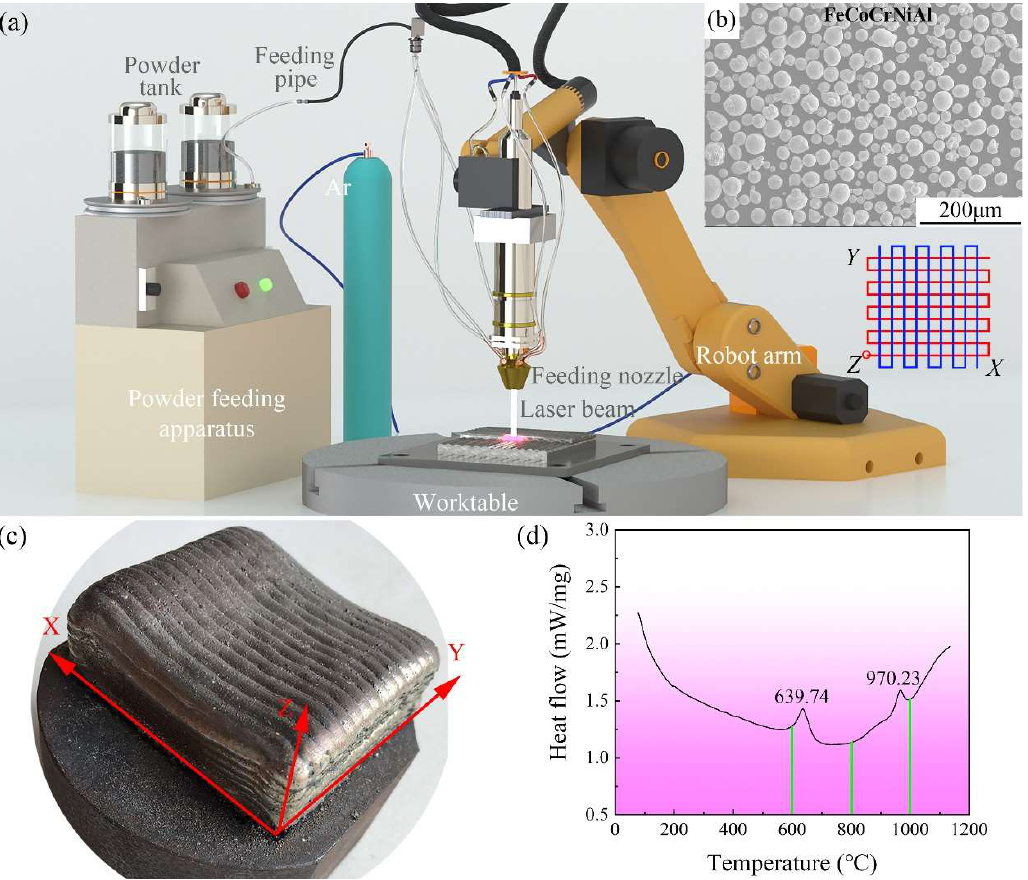
Figure 1. ( a ) Laser-melting deposition system; ( b ) AlCoCrFeNi powders; ( c ) the fabricated AlCoCrFeNi component; ( d ) DSC analysis results for the fabricated AlCoCrFeNi component.